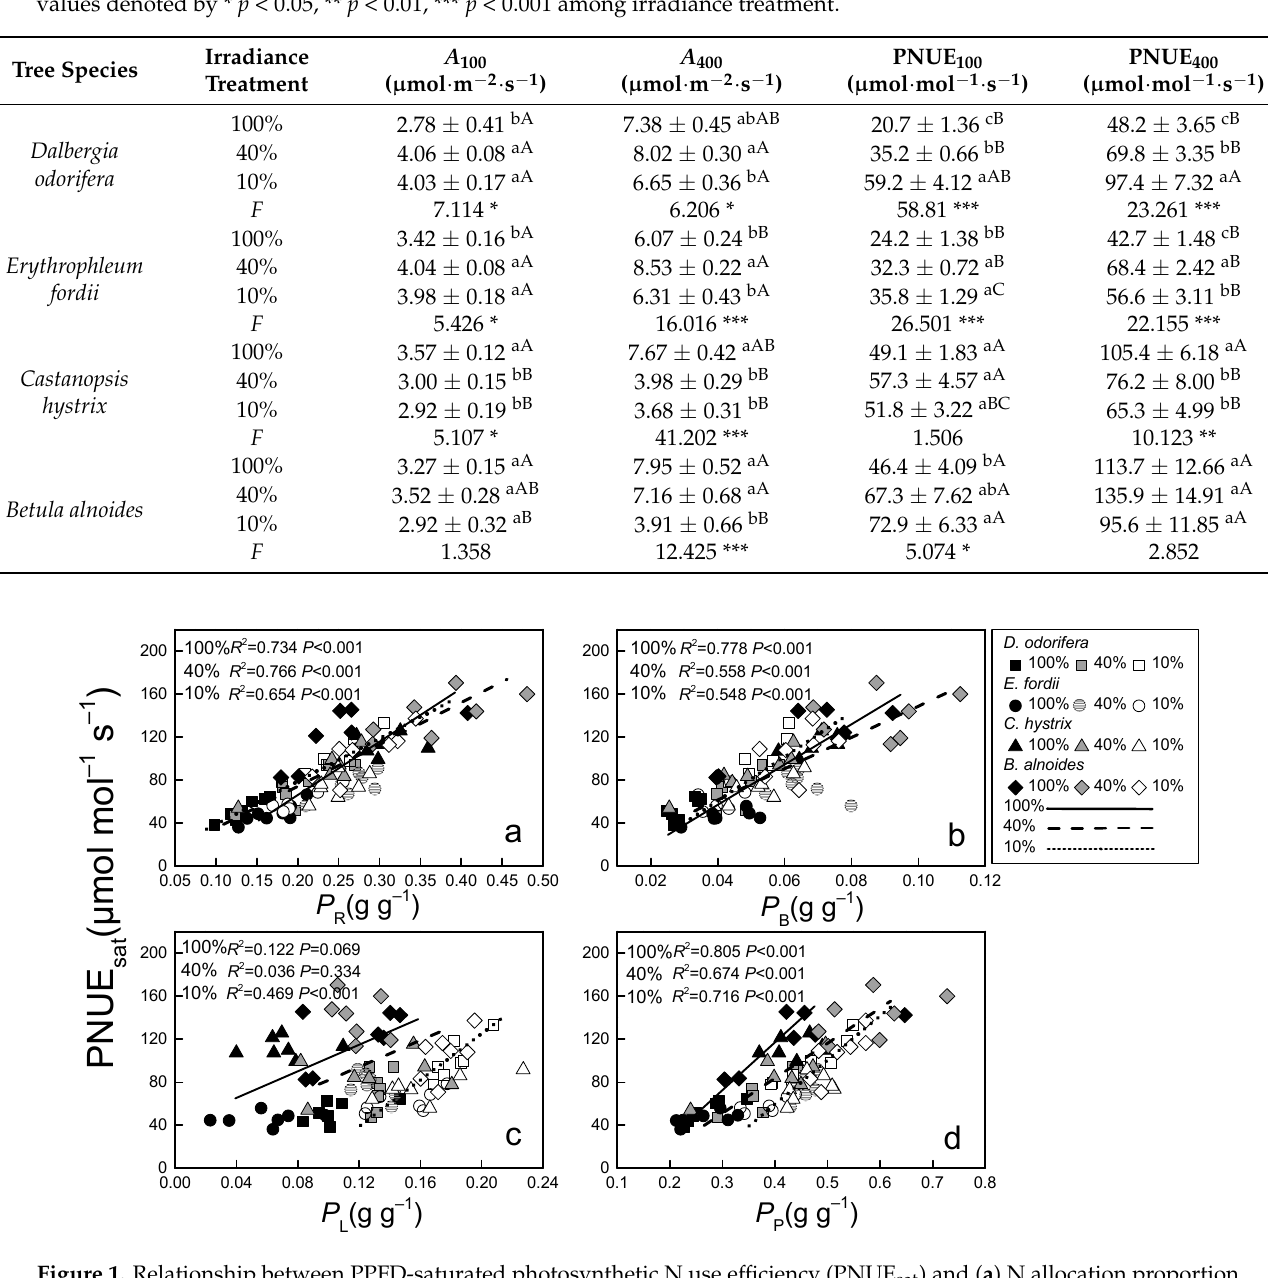
Table 6. Net CO 2 assimilation rate at PPFD of 100 umol · m − 2 · s − 1 ( A 100 ); net CO 2 assimilation rate at PPFD of